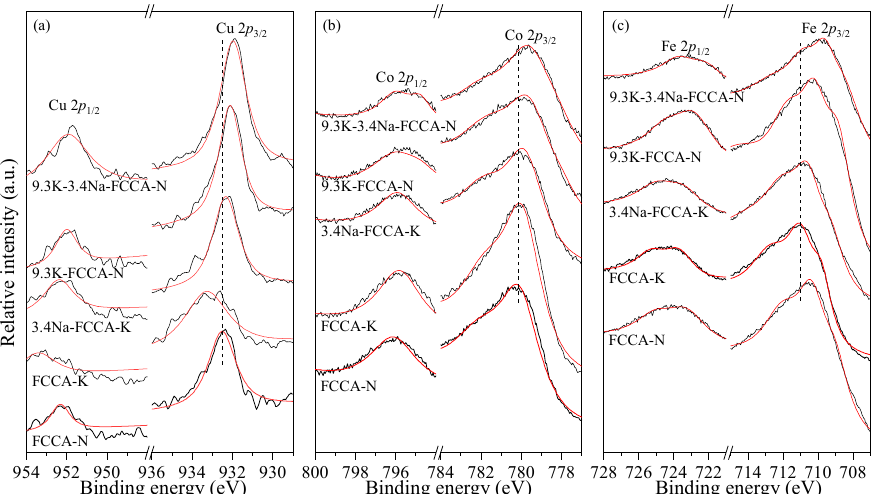
Figure 5. 2p XPS spectra of Cu ( a ), Co ( b ) and Fe ( c ) in reduced FeCoCuAl catalysts before and after K and/or Na modification. Catalyst reduction at 400 ◦ C for 1 h in pure H 2